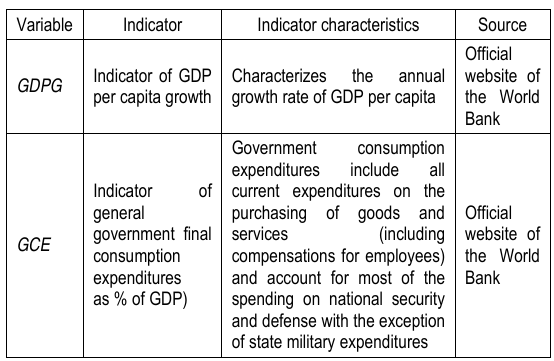
Table 5. Characteristics of the